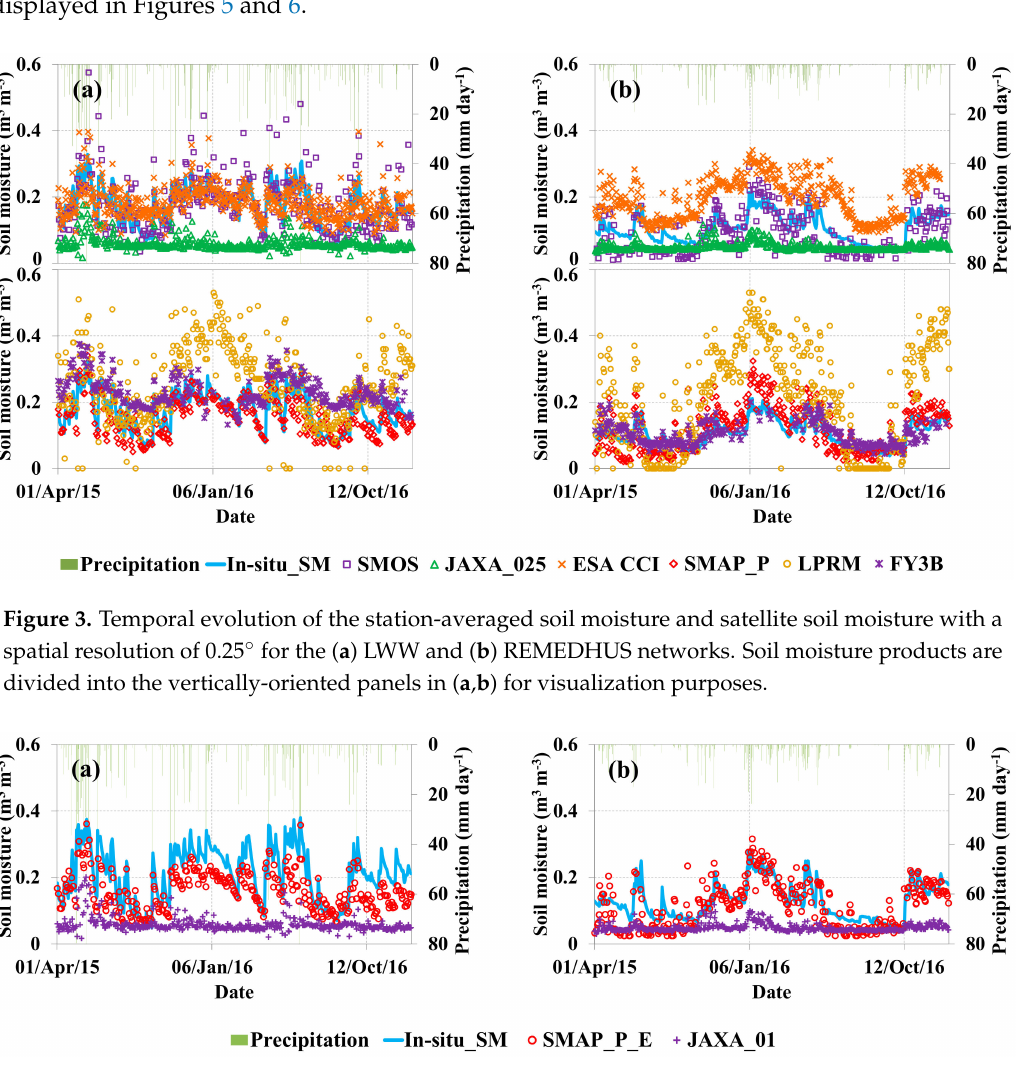
Figure 4. Temporal evolution of the station-averaged soil moisture and satellite soil moisture with a spatial resolution of 0.1 ◦ for the ( a ) LWW and ( b ) REMEDHUS